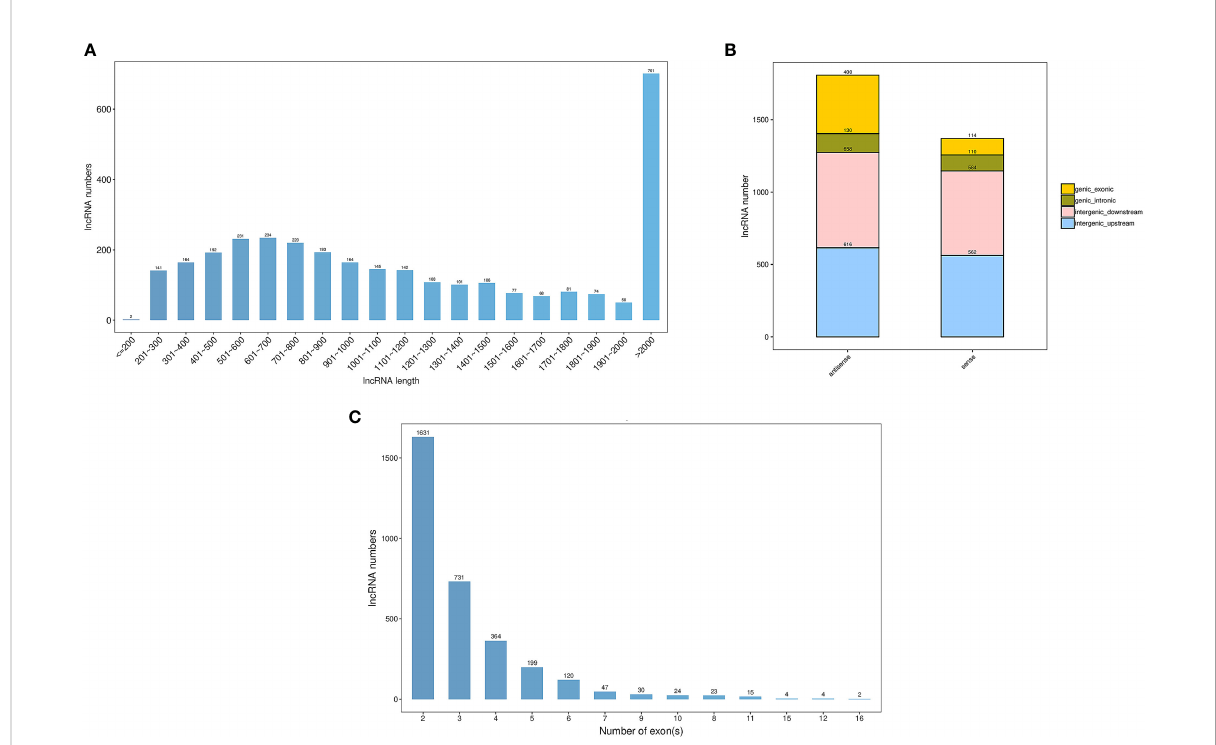
FIGURE 2 Summary of the characteristic long noncoding RNAs (lncRNAs) in pomegranate. (A) The length distribution of IncRNAs, (B) The classi fi cation of IncRNAs and (C) The exon number of